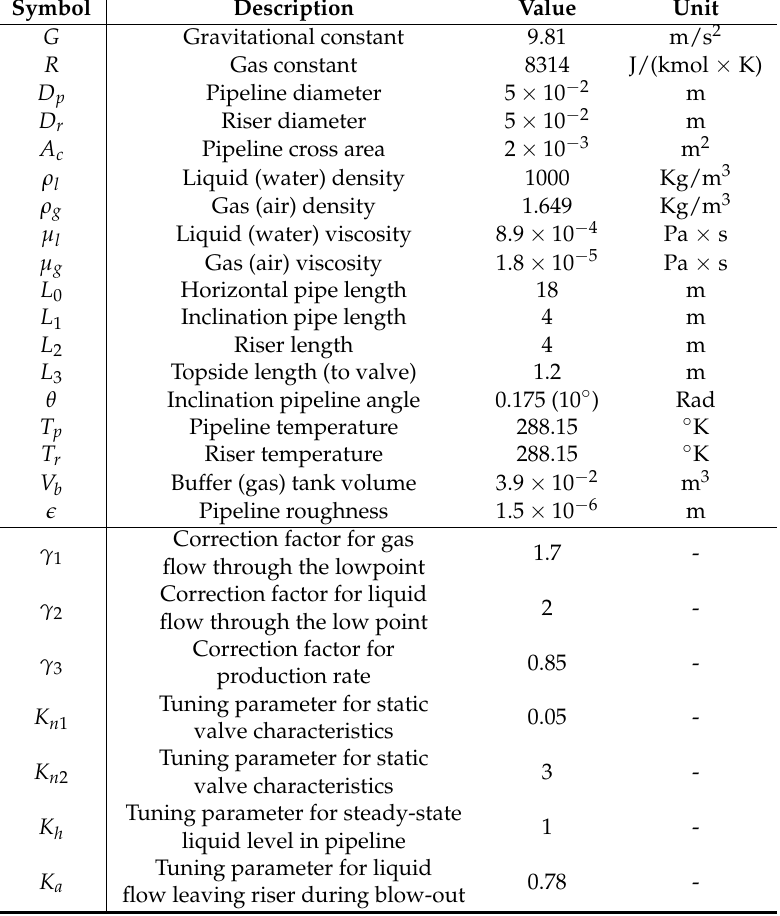
Table 1. A collection of the identified constants for the model of the testing